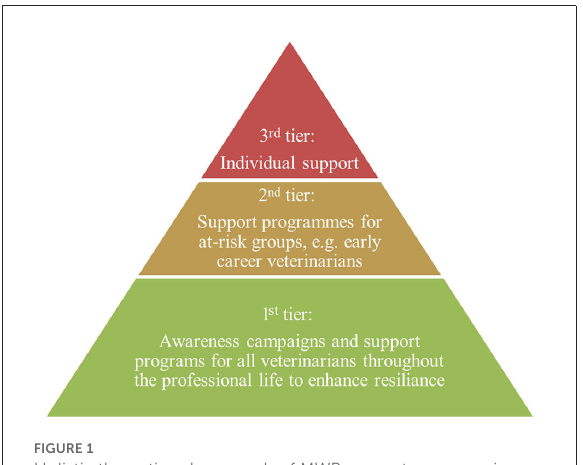
FIGURE1 Holistic three-tiered approach of MWB support programs in veterinary medicine (adapted from Moir and Van den Brink (45)).